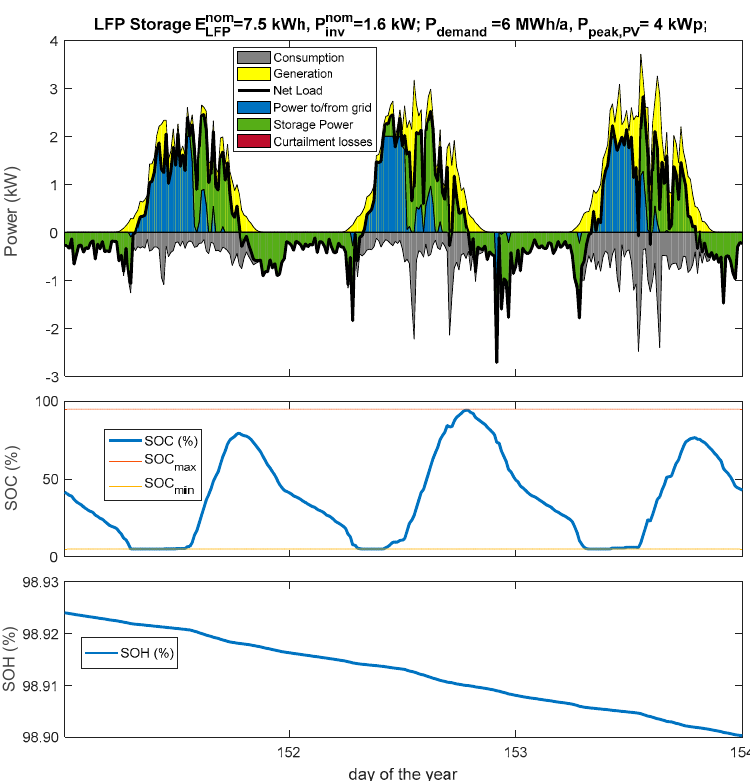
Figure 2. Power flow analysis for a three-day period using lithium-iron-phosphate (LFP) battery